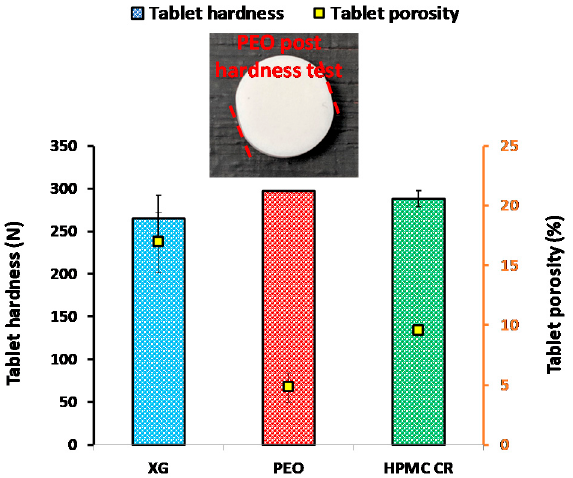
Figure 4. Polymer compact properties of hardness and porosity assessment for the three polymers tested. Note: XG is xanthan gum, PEO is polyethylene oxide, and HPMC CR is hypromellose K100M grade. Insert is a photograph highlighting the deformation that occurred to the polyethylene oxide (PEO) compacts during the hardness test. The red dashed lines indicate the sides of the tablet deformed during testing.